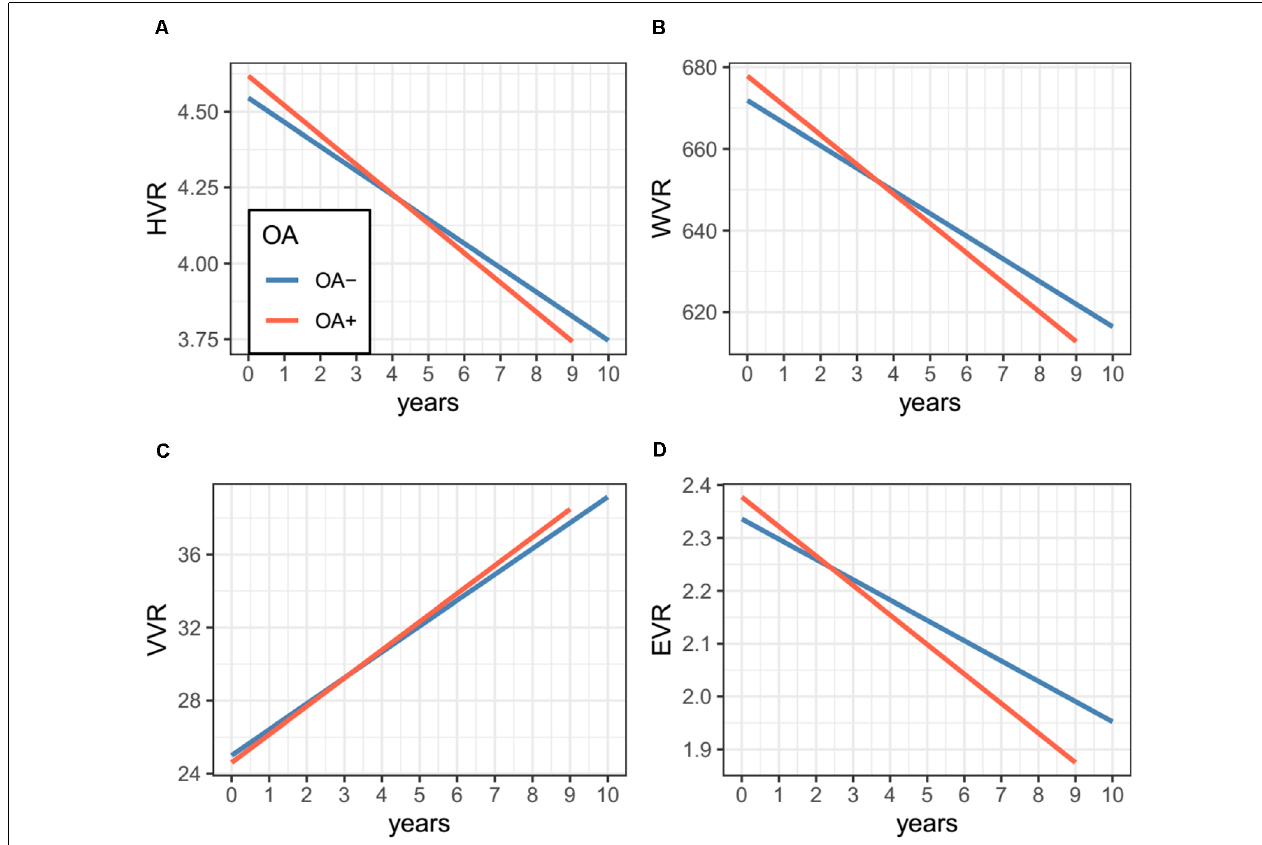
FIGURE 2 | Association of OA status with changes in MRI markers over time among non-demented older adults. Panel (A) shows that OA status was not associated with the change in HVR. Panel (B) shows that compared with participants without OA, those with OA showed a significantly steeper decline in WVR. Panel (C) shows that OA status was not associated with a change in VVR. Panel (D) shows that OA status was not associated with the change in EVR. Abbreviations: OA, Osteoarthritis; HVR, Hippocampal volume ratio; WVR, Whole brain volume ratio; VVR, Ventricles volume ratio; EVR, Entorhinal volume ratio.